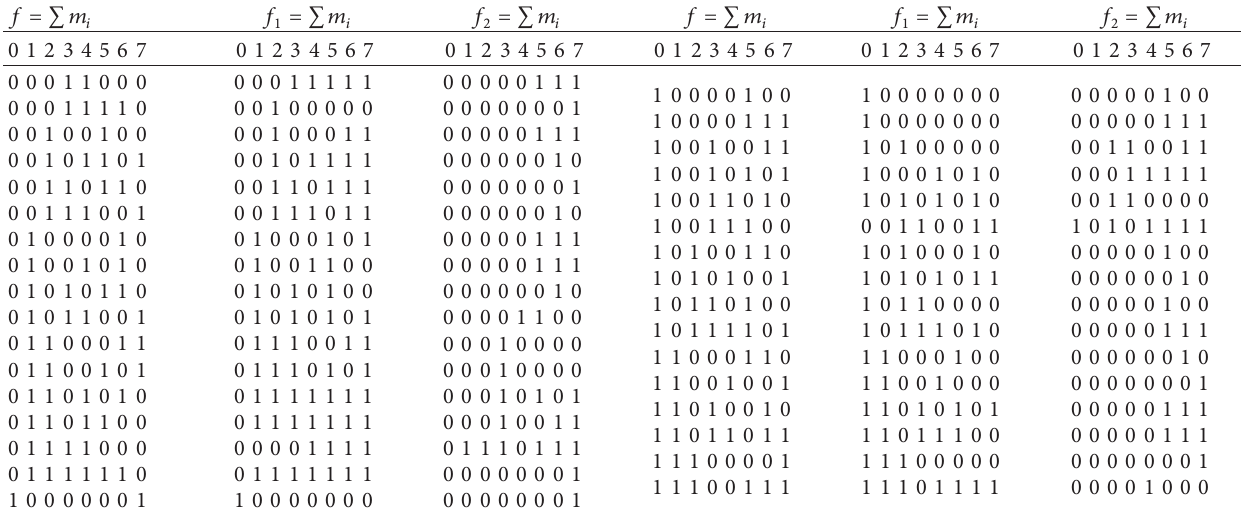
Table 3: The third category of the three-variable nonthreshold